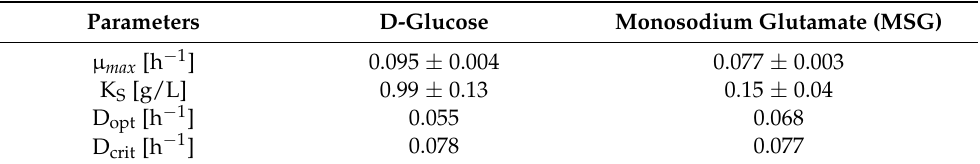
Table 2. Affinity constants (K S ) and maximum growth rates (µ max ) for D-glucose and monosodium glutamate, obtained by fitting the growth rates versus the substrates concentration in the superna- tant to the Monod equation with SigmaPlot. With the obtained values, the optimal (D opt ) and criti- cal dilution rate (D crit ) were calculated.